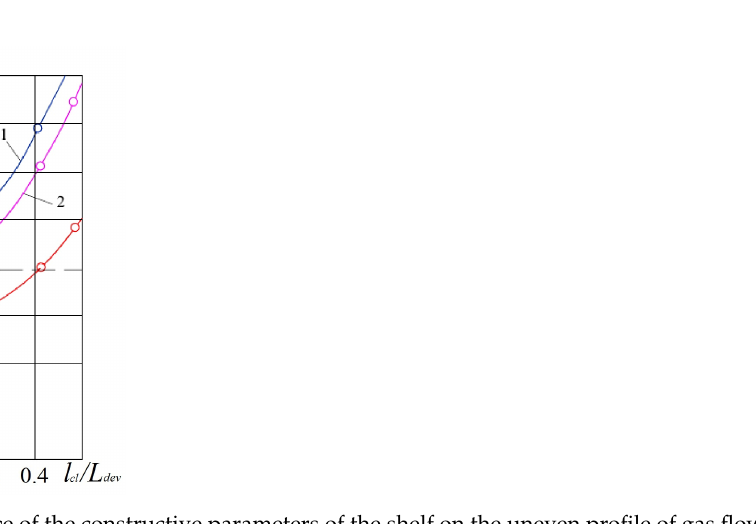
Figure 6. The influence of the constructive parameters of the shelf on the uneven profile of gas flow velocities. Degree of the shelf perforation ψ : 1–3—respectively, 5%, 15%, 30%. The tilt angle of the shelf— γ = 25°. Gas flow velocity in the free cross-section—1.65 m/s.